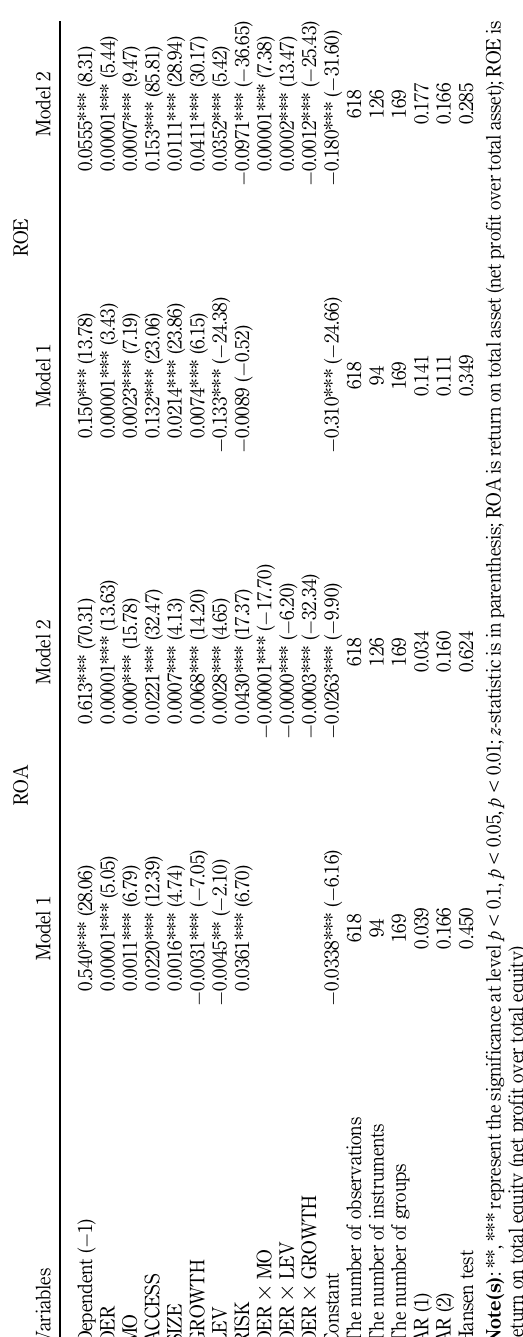
Table 5. Robustness test (ROA and